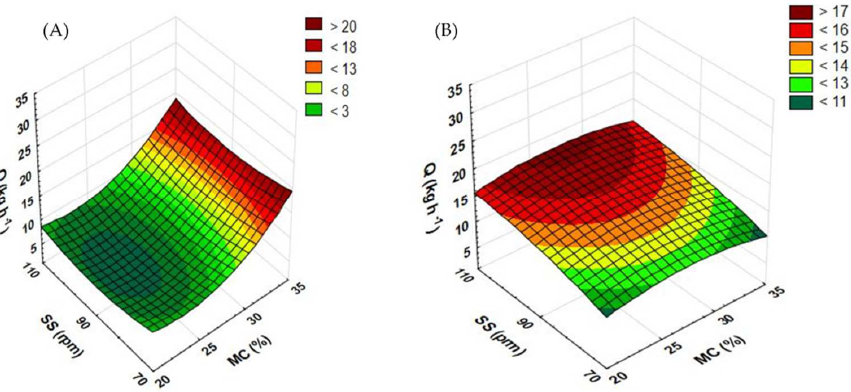
Figure 5. Efficiency of the extrusion-cooking of rapeseed straw ( A ) and buckwheat straw ( B ) after modification of the plasticizing system: MC—moisture content; SS—screw speed; Q—efficiency.